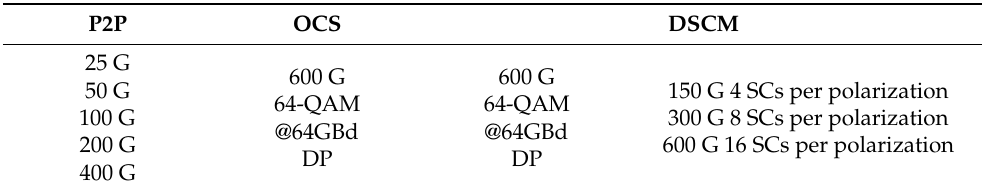
Table 2. Available transceivers for P2P, OCS, and DSCM.